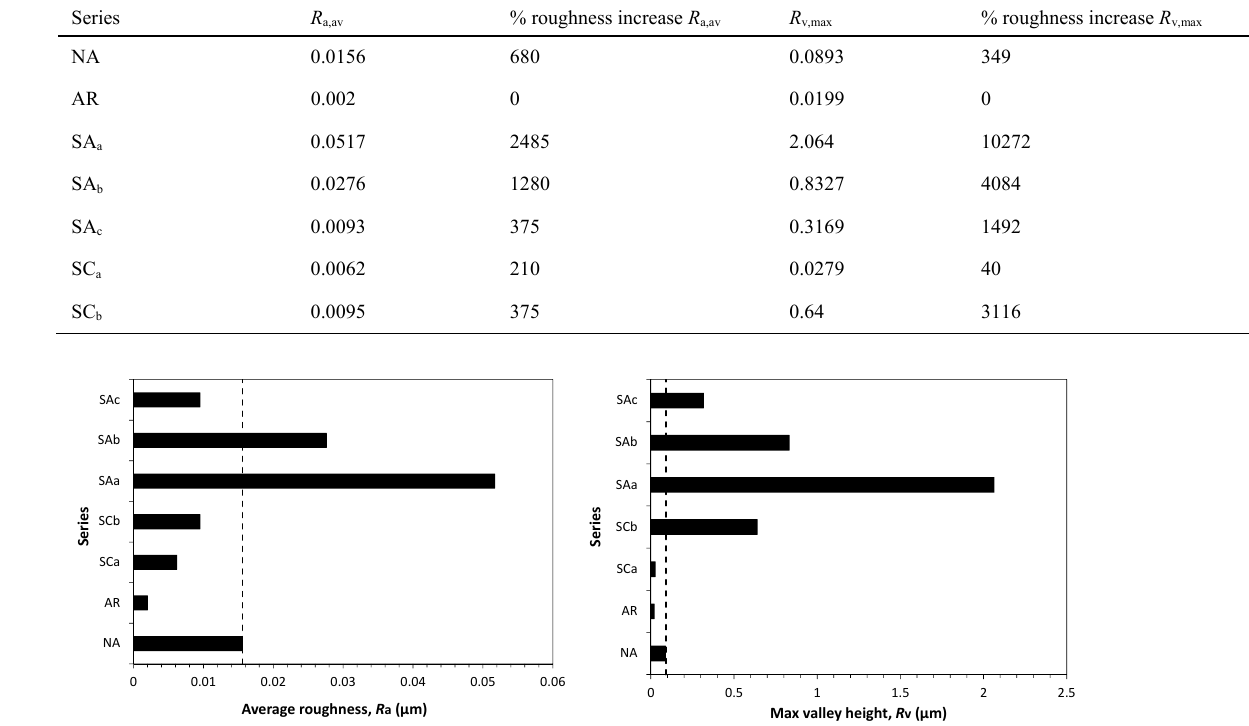
Fig. 6 Comparative roughness results for all tested series: (a) average roughness and; (b) maximum valley